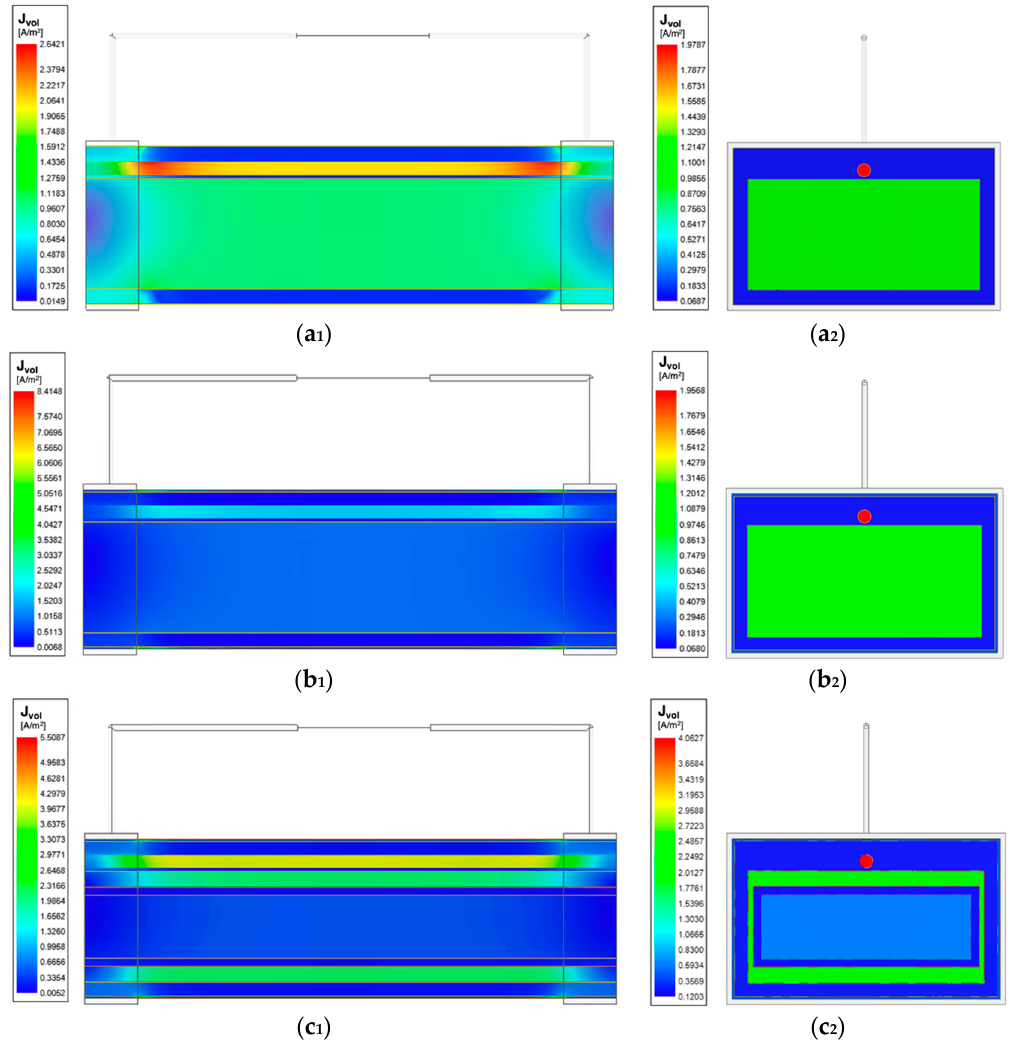
Figure 12. Current density overlay of stepwise ‐ updated wrist models at 100 kHz: ( a 1 ) horizontal cross ‐ section of the wrist model 1; ( a 2 ) vertical cross ‐ section of the wrist model 1; ( b 1 ) horizontal cross ‐ section of the wrist model 2; ( b 2 ) vertical cross ‐ section of the wrist model 2; ( c 1 ) horizontal cross ‐ section of the wrist model 3; ( c 2 ) vertical cross ‐ section of the wrist model 3.